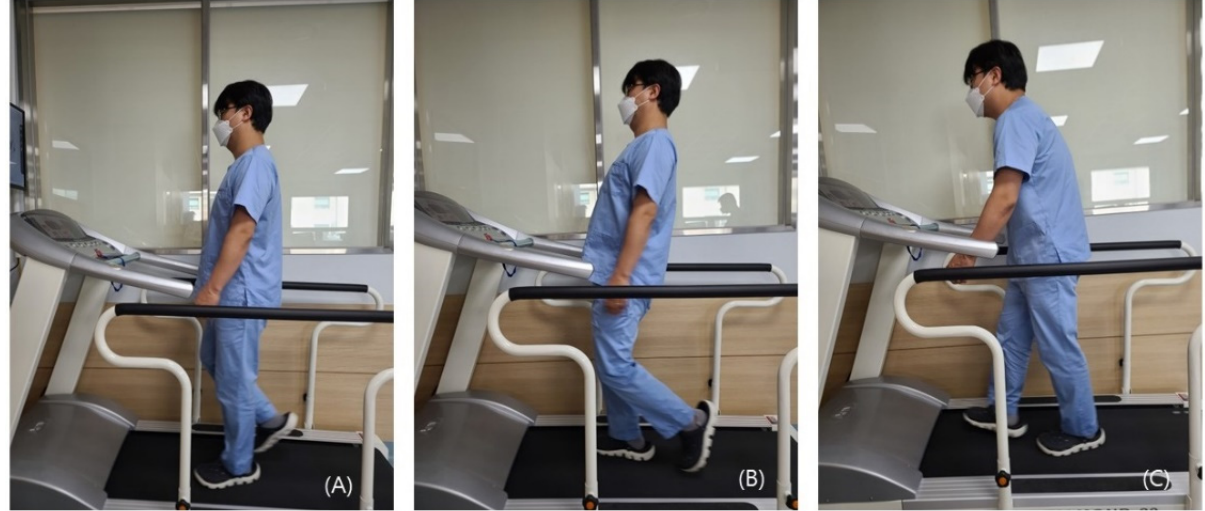
Figure 3. Three different gait postures: ( A ) normal gait; ( B ) sway back; ( C ) thoracic kyphosis.